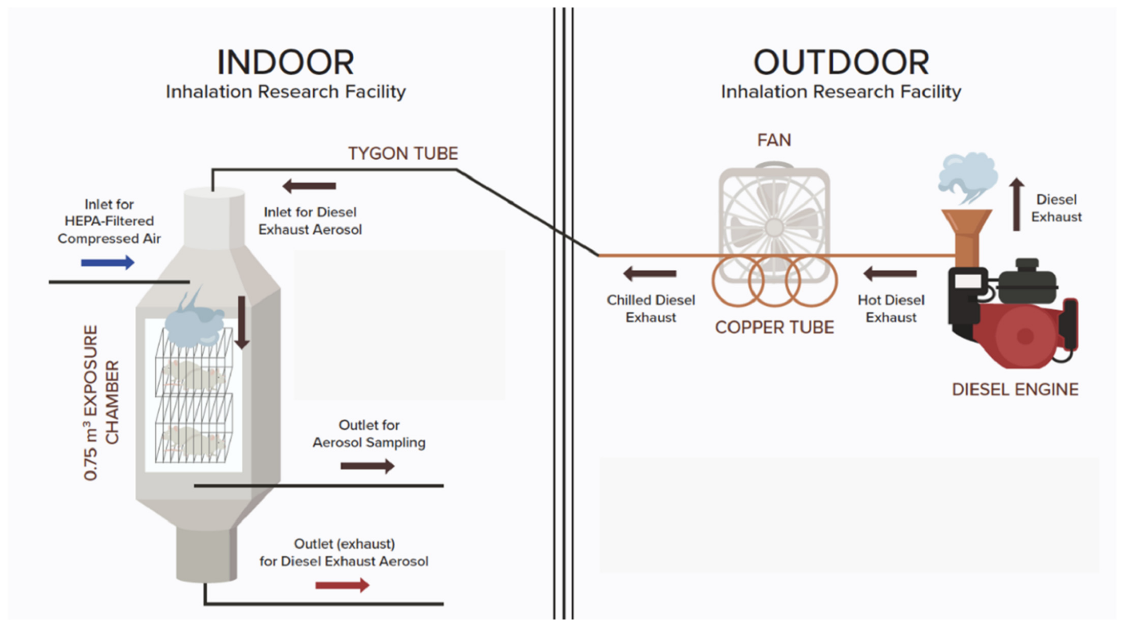
Figure 6. Schematic of the experimental set ‐ up. Diesel exhaust aerosol generation and mouse expo ‐ sure systems. This schematic is not to scale.